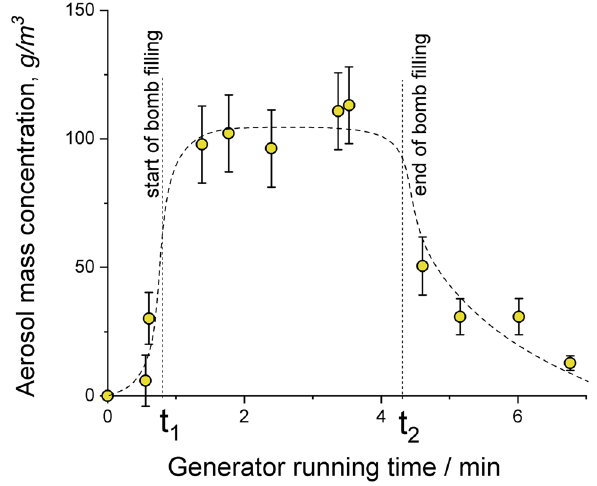
Fig. 10 Aerosol mass concentration at the bomb inlet as a function of the generator running time. Symbols—experimental measurements, dash line is an eye